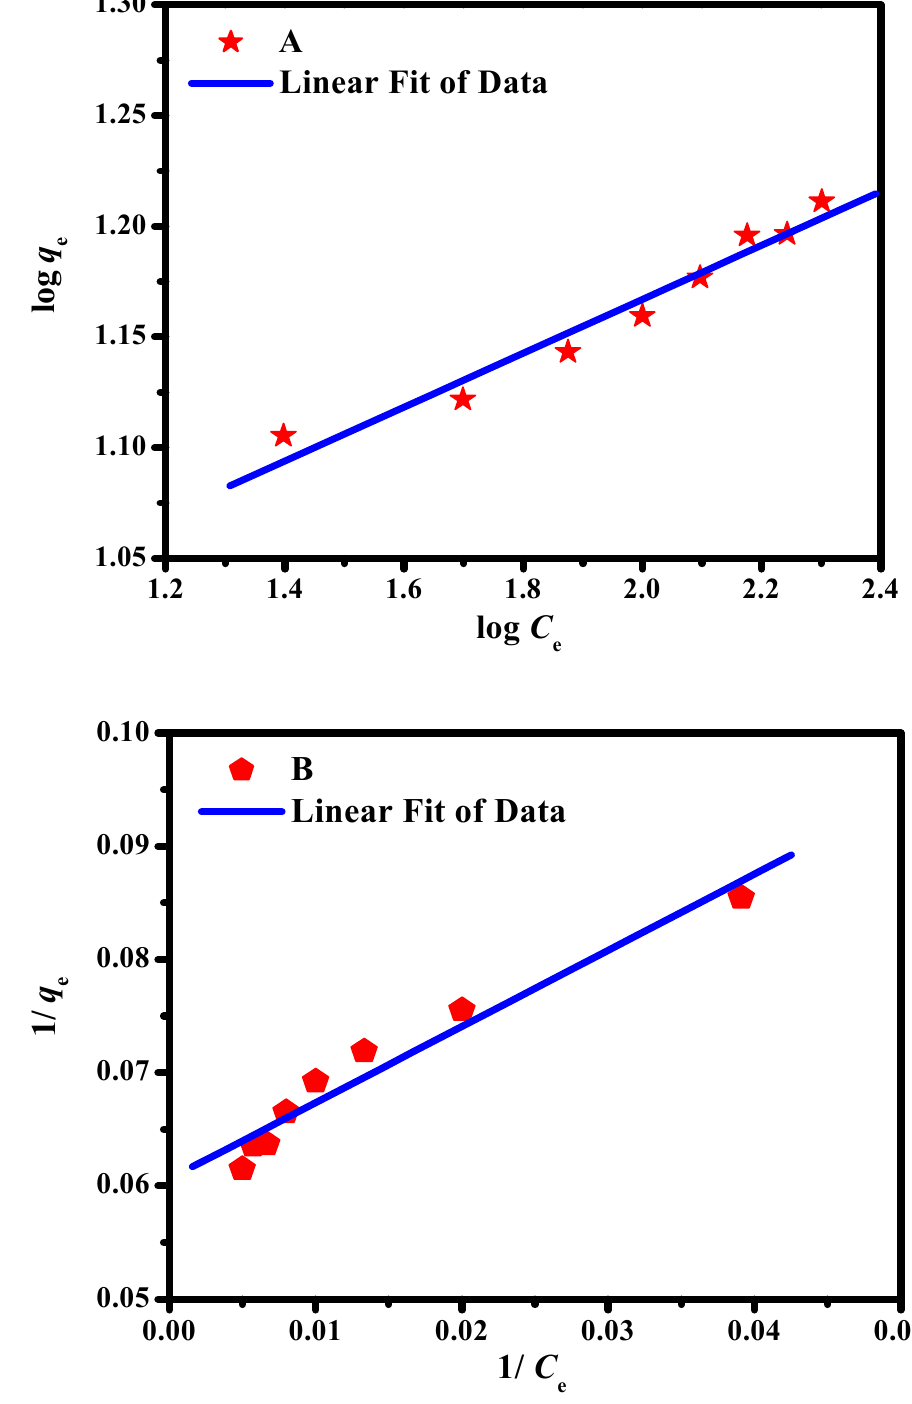
Figure 6. Linear diagrams of ( A ) Freundlich and ( B ) Langmuir models for Cr (VI) removal; pH = 2, sorbent weight = 0.6 g/100 mL Cr(VI).